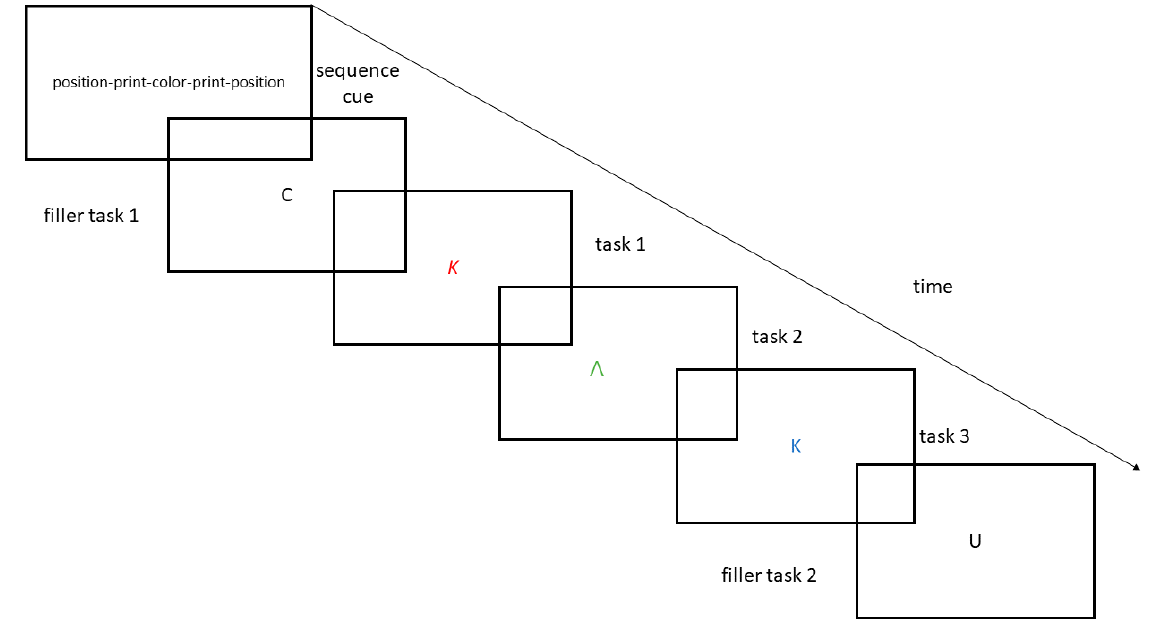
Figure 1. Schematic illustration of the used paradigm.